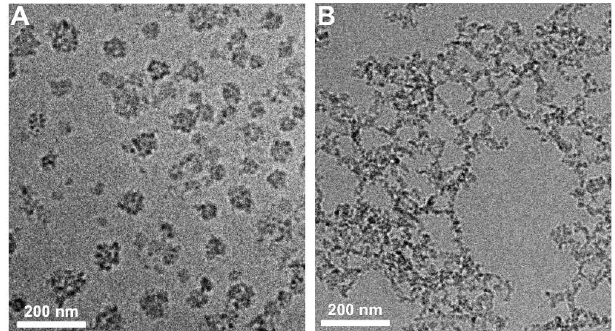
Figure 3. Cryo-TEM micrographs of NG/a-miR21-3 without ( A ) and with ( B ) GSH treatment. Scale bar = 200 nm.